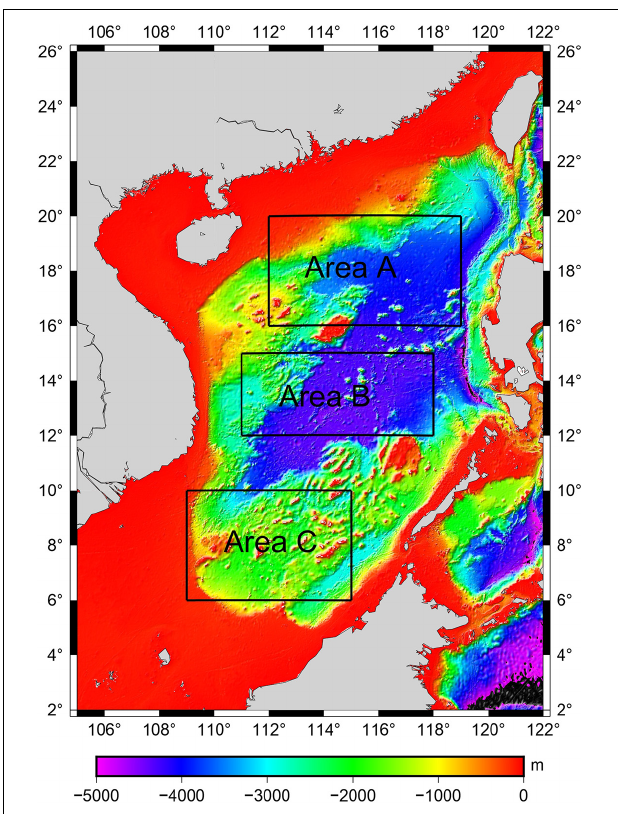
FIGURE 3 | HY-2A/GM-derived 1 arc min gravity anomalies map in the